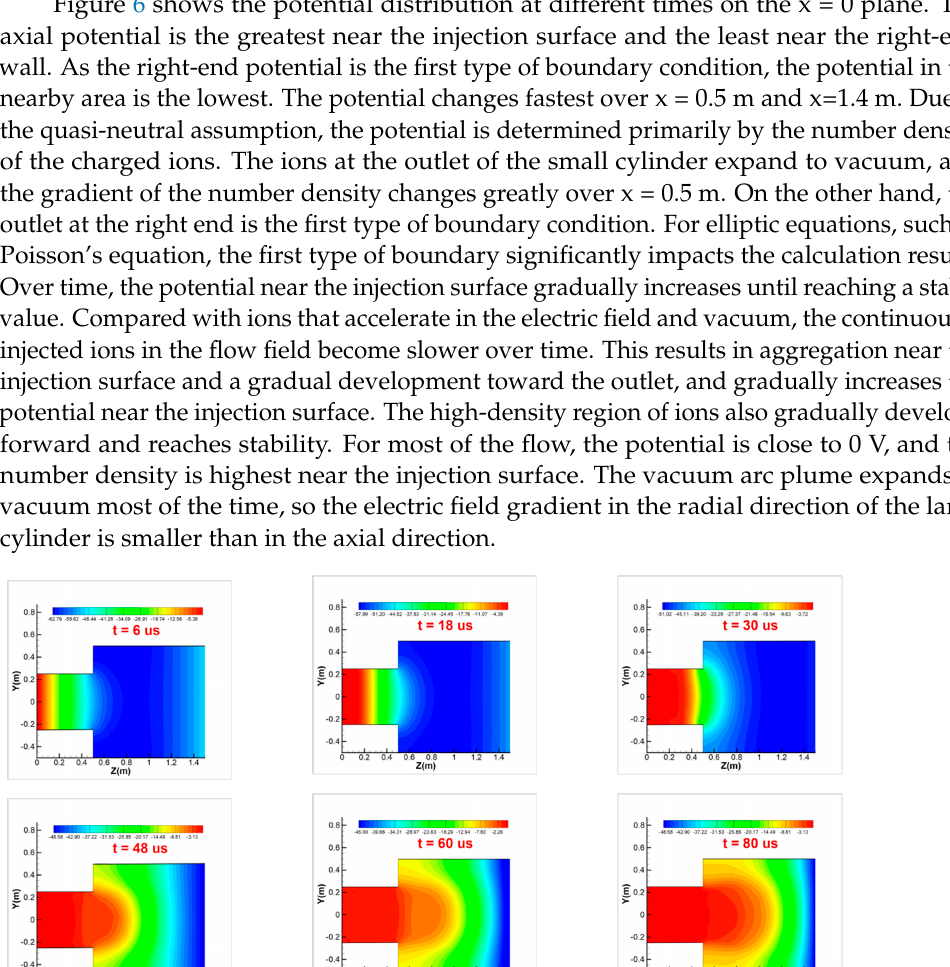
Figure 5. Velocity and number density distribution of atomic Ti at different times on the x = 0 plane.